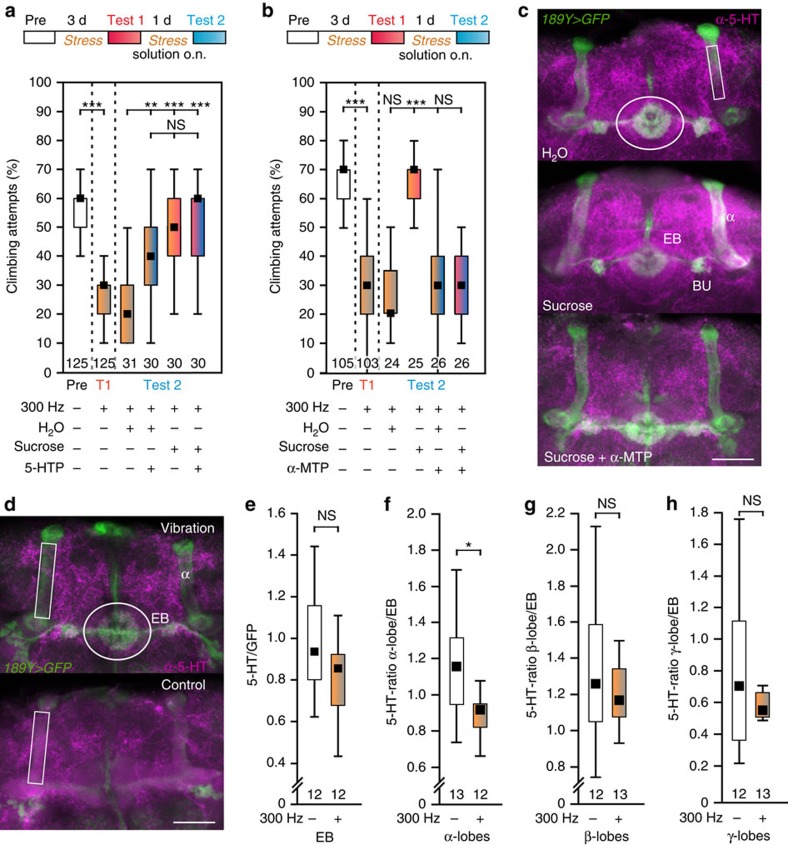
Serotonin level in mushroom body α-lobes correlates with the depression-like state.(a) Reduced fraction of climbing attempts after 3 days of vibration treatment is ameliorated by feeding the serotonin precursor 5-hydroxy-L-tryptophan (5-HTP; 1 mg ml−1) overnight. Sucrose solution (5%) or sucrose solution with 5-HTP overnight ameliorate insignificantly more effectively (Kruskal–Wallis test). (b) Sucrose solution ameliorates the depression-like state; however, not when the 5-HT-synthesis blocker α-methyl-DL-tryptophan (α-MTP; 20 mM) is added (Kruskal–Wallis test). (c) Sucrose treatment is signalled via 5-HT release in the fly brain. Three 22.5 μm thick layers of confocal stacks stained with 5-HT antibody (magenta) showing the ellipsoid body (EB; ring), R3 ring neurons (dendrites in the bulbs, BU), and α-lobes of mushroom bodies merged with the expression pattern of 189Y-GAL4>UAS-mCD8::GFP. Fly brains were prepared on day 4 after 3 days on food and the following night either on water, on 5% sucrose solution, or on 5% sucrose solution with 20 mM α-MTP; quantification of 5-HT labelling divided by the GFP signal at the indicated regions in Supplementary Fig. 2. (d–h) 5-HT in flies in a depression-like state compared to controls. Elliptic region of interest around EB is compared to rectangular regions around each mushroom-body lobe (example in d shows α-lobes). Grey values of all pixels with common x-/y-coordinates were summed up along the z axis (creating voxels) and voxel means determined. (e) Relative 5-HT content of EB; GFP-label for reference. (f–h) ‘5-HT lobe staining' in the indicated mushroom body lobes divided by ‘5-HT EB staining'. Black squares, medians; boxes, 25 and 75% quartiles; whiskers, 10 and 90% quantiles; numbers of animals are indicated below each box; NS, not significant; *, P<0.05; **, P<0.01; ***, P<0.001; Mann–Whitney U test was used in e–h. Scale bars denote 25 μm.